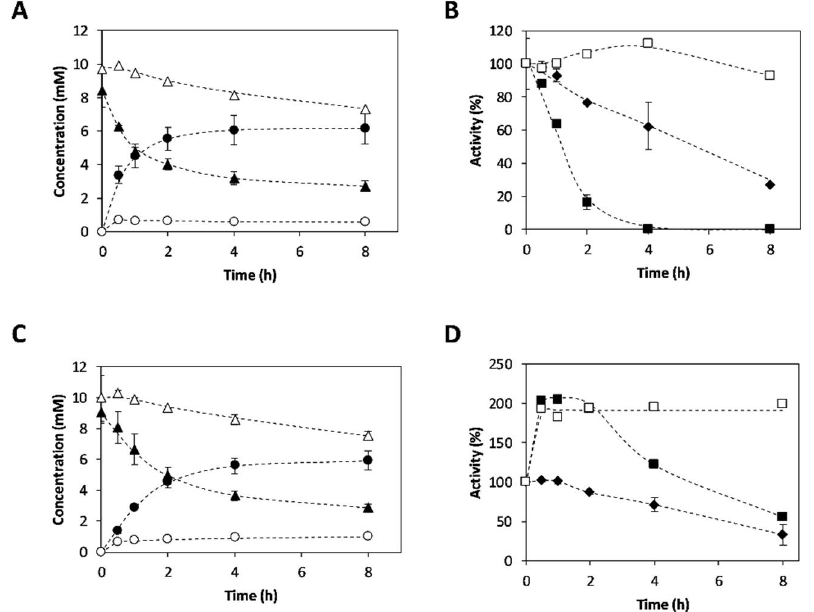
Figure 4. Reaction time courses of 3-APB synthesis and operational enzymatic stability. ( A ) Reaction time courses performed with CviTA and ( C ) VflTA: ( ) 3-APB concentration in cascade reactions; ( ) 3-APB concentration in reactions without PDC; ( ) 4-PB concentration in cascade reactions; and ( ) 4-PB concentration in reactions without PDC. ( B ) Operational stability of CviTA and ( D ) VflTA, as well as PDC when cascade reactions were performed: ( ) Transaminase activity in cascade reactions. ( ) Transaminase activity in reactions without PDC. ( ) PDC activity. Reaction conditions: 30°C; pH 7.5; 4-PB 10 mM; L-Alanine 200 mM; TA 5% v v −1 ; PDC 25% v v −1 , 1 mM pyridoxal5’-phosphate (PLP), 0.1 mM thiamine pyrophosphate (TPP), and 0.1 mM MgCl 2 . Concentration values are reported in Tables S1–S4.